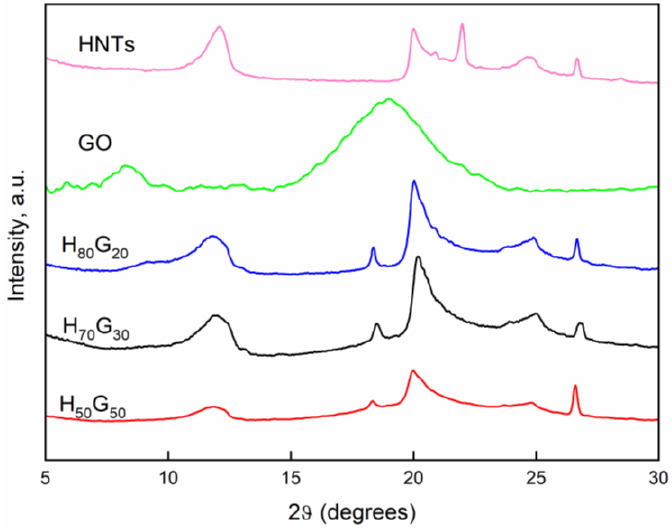
Figure 1. XRD pattern of halloysite nanotubes (HNTs), grapefruit seed oil (GO), and nano-hybrids (H x G y